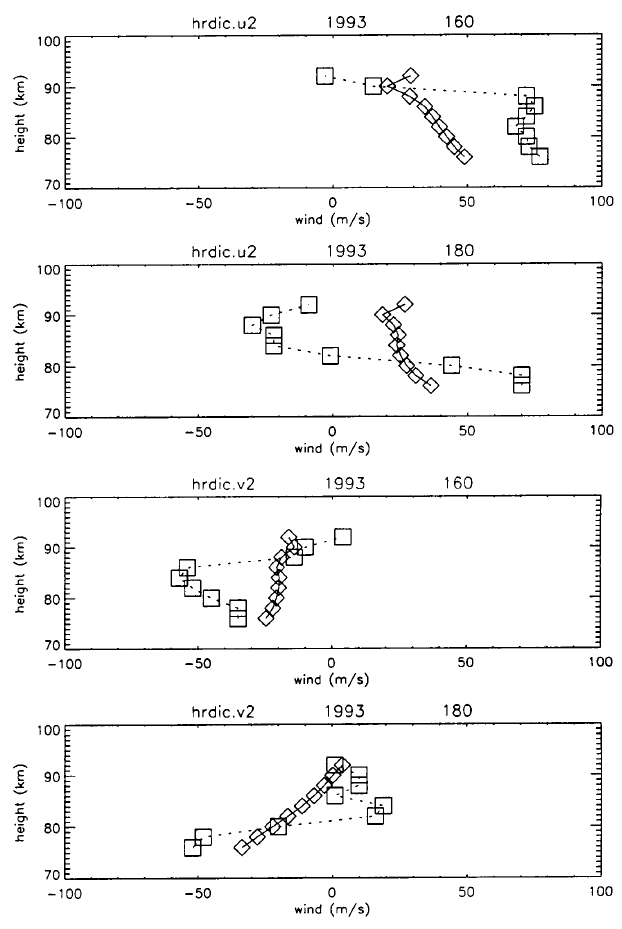
Fig. 6. Zonal winds (upper two panels) and Meridional winds (lower two panels) from two overpasses in June 1993. Radar winds from Birdlings Flat (squares) and HRDI (diamonds). The radar data has been integrated for a period of one hour either side of the time of the